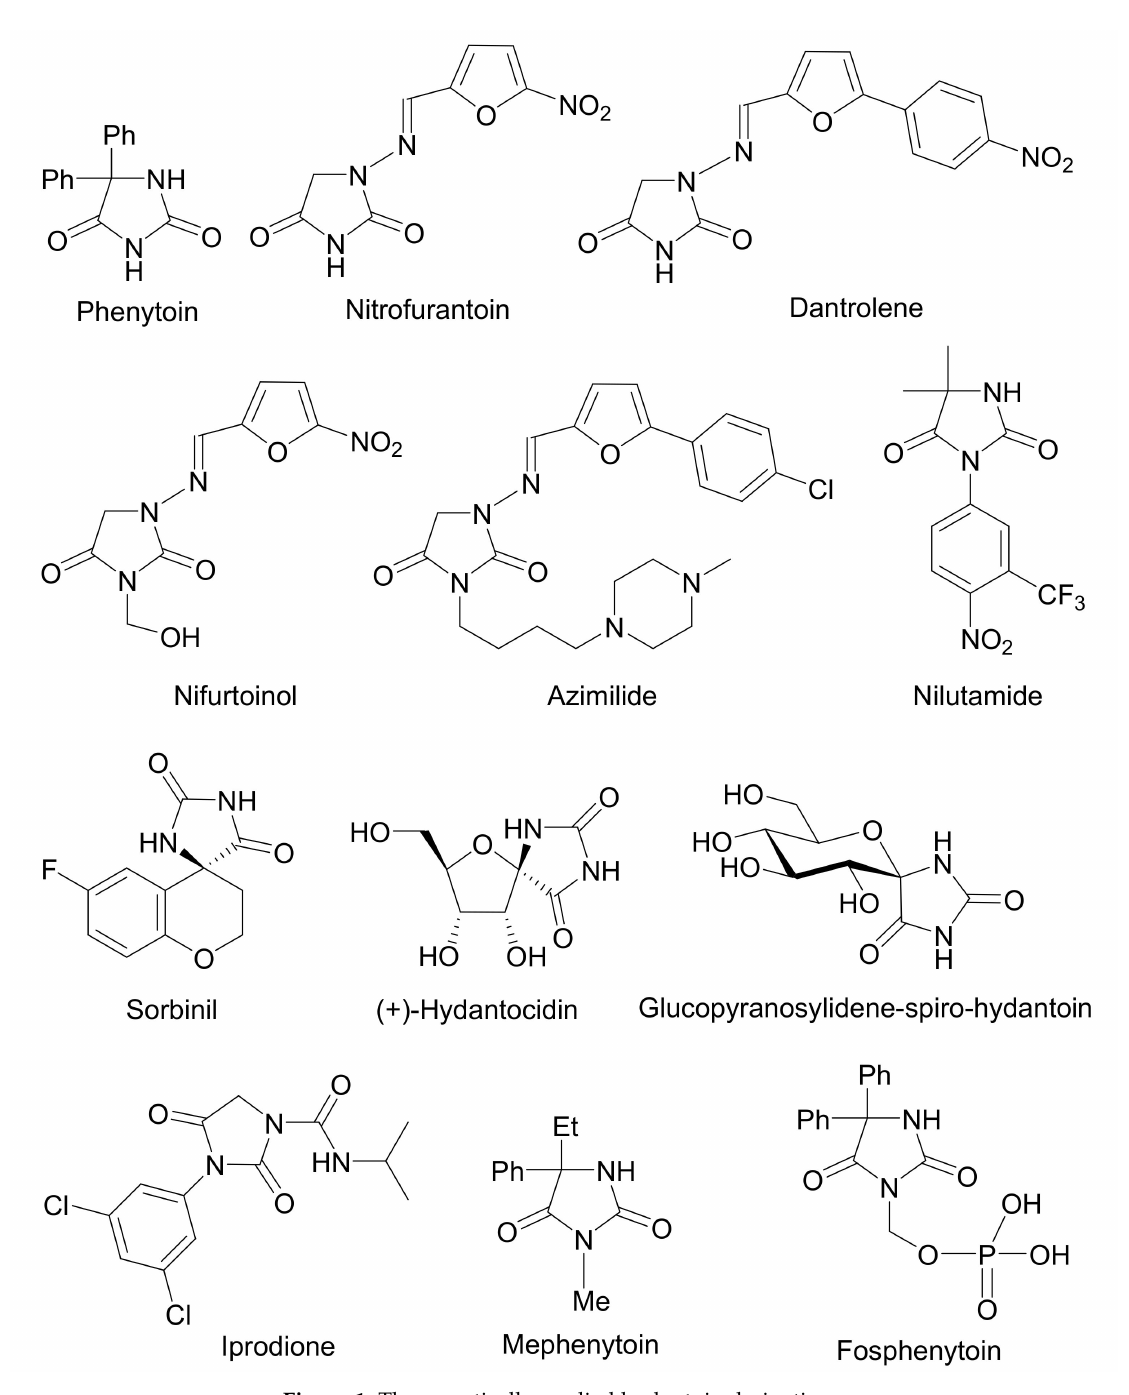
Figure 1. Therapeutically applied hydantoin